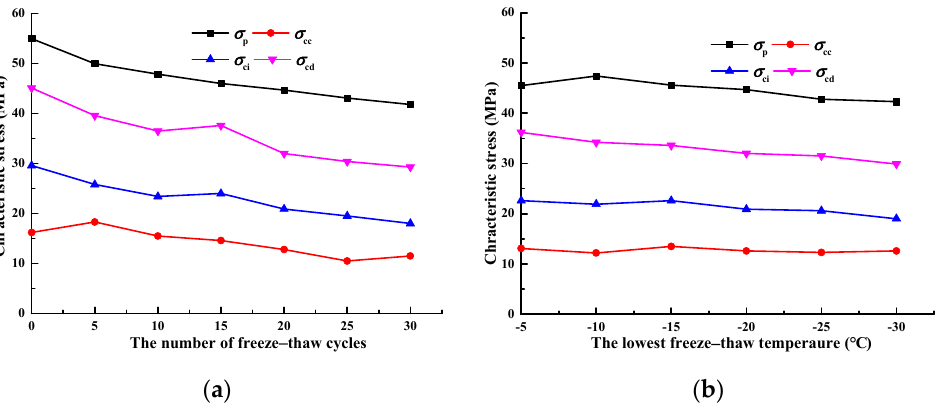
Figure 9. Characteristic stress of the sandstone samples: ( a ) with different freeze–thaw cycles ( T = − 20 °C); ( b ) with different freeze–thaw temperatures ( N = 20).